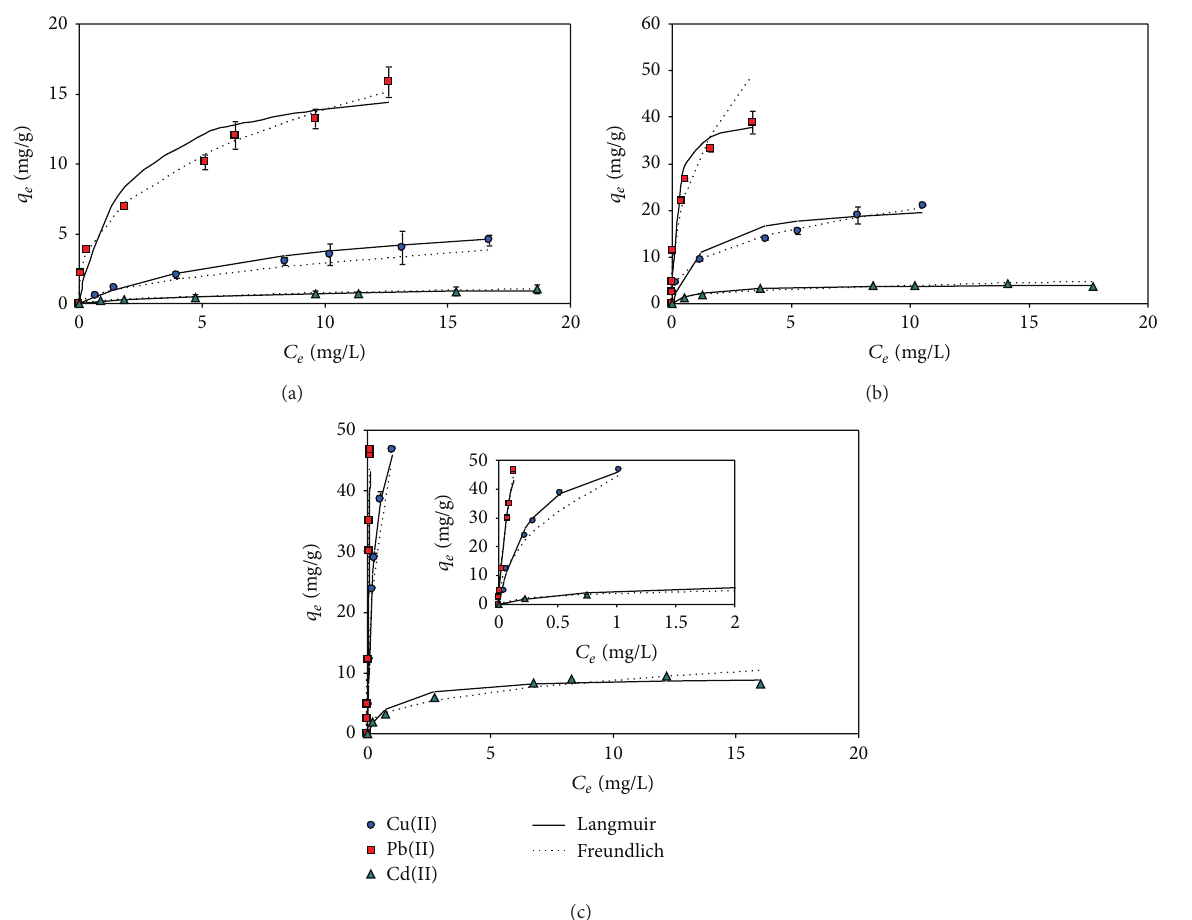
Figure 4: Adsorption isotherms of Cu(II), Pb(II), and Cd(II) on magnetic GO at pH 4.0 (a), 6.0 (b), and 7.0 (c) under the single-metal